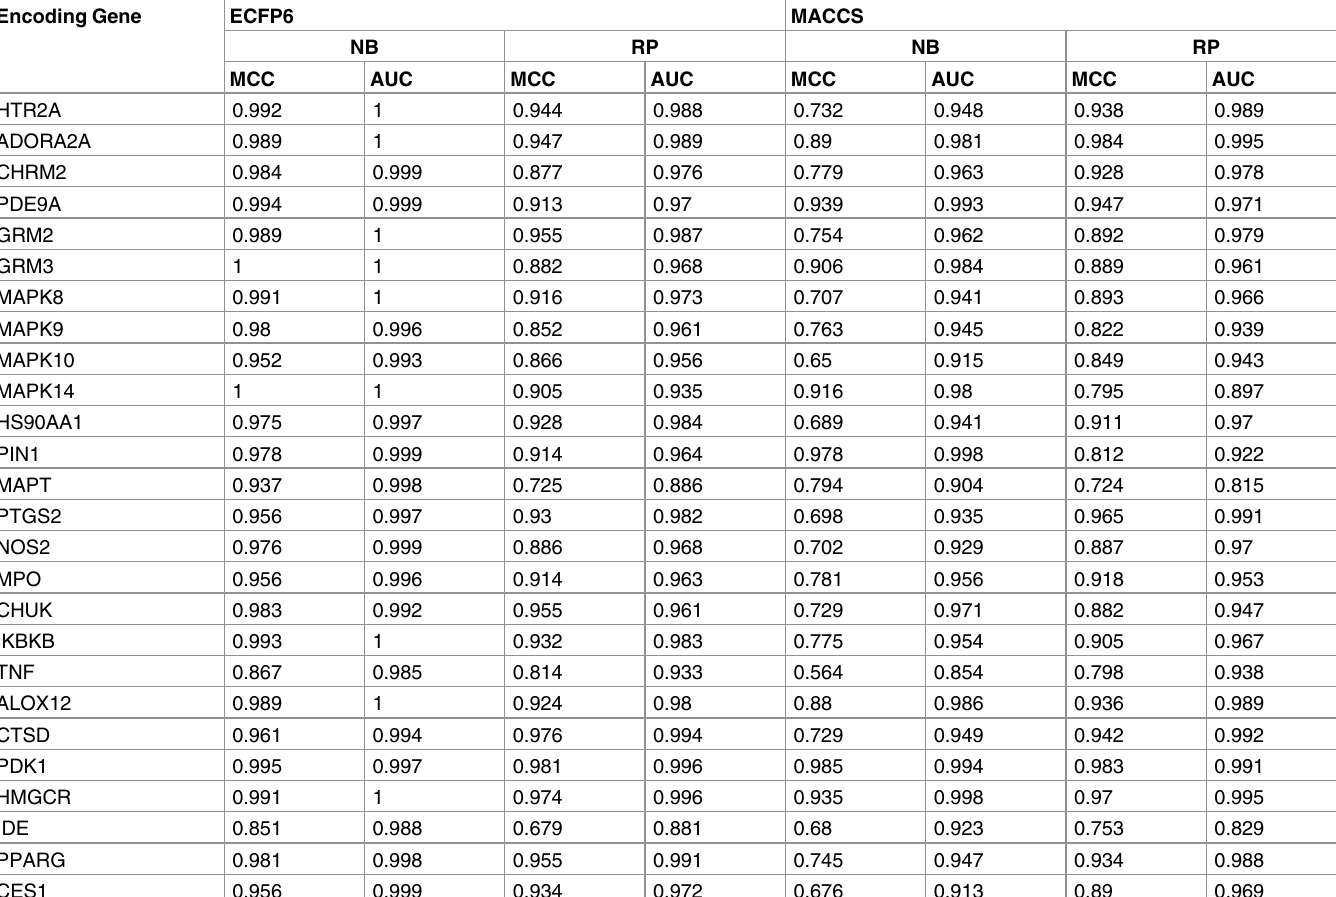
Table 2. Performanceof the 5-fold cross-validation for 26 targets towards Alzheimer disease using NB and RP classifiers. Encoding Gene